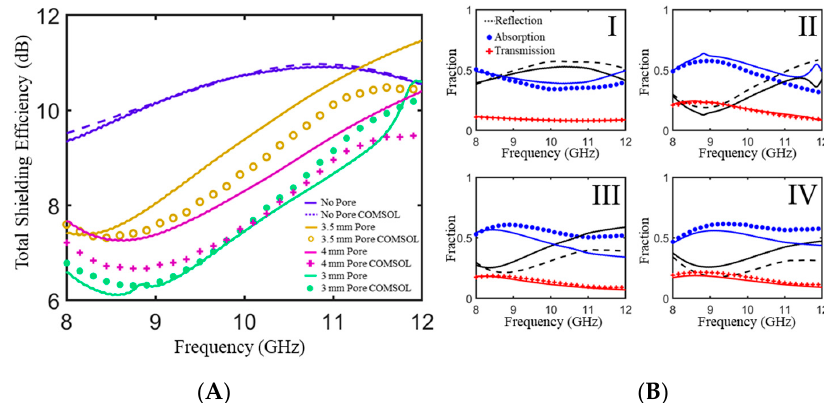
Figure 7. ( A ) Measured and simulated total shielding efficiency in an X-band waveguide for a 5% M21/PLA composite plaque with and without pores of varying height. ( B ) Measured and simulated power balance for a 5% M15/PLA composite plaque (I) without pores, (II) a cylindrical pore with a height of 3 mm, (III) a cylindrical pore with a height of 3.5 mm, and (IV) a cylindrical pore with a height of 4 mm. All plaques have a total thickness of 4.6 mm. All cylindrical pores have a diameter of 2.54 mm. Simulated data is depicted with symbols and experimental data is represented by solid lines of the same color.